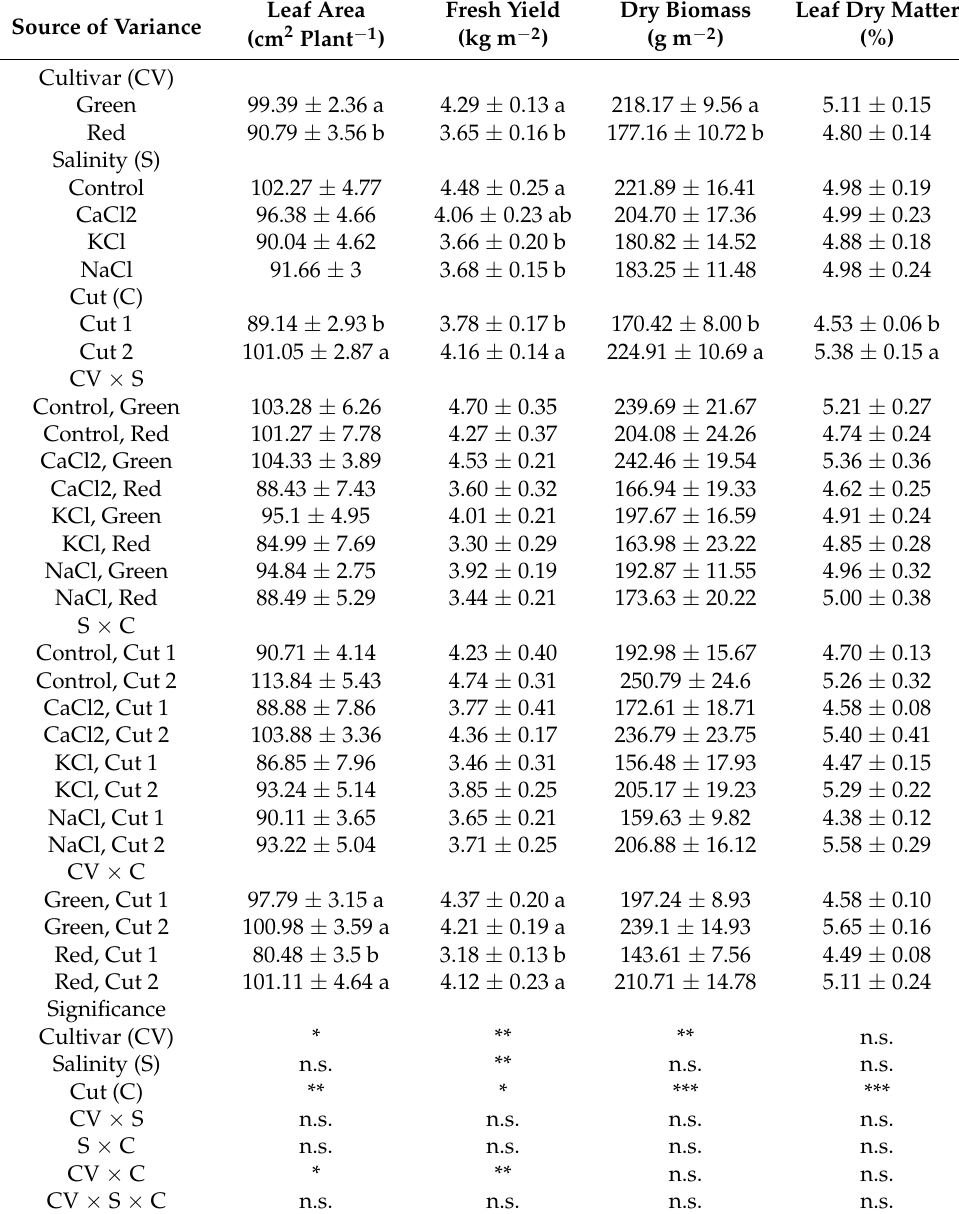
Table 1. Significance of the main factors (cultivar, salinity, and cut order) and their interactions on the leaf area, fresh yield, dry biomass, and leaf dry matter percentage of Lactuca sativa L. var. acephala grown in a floating